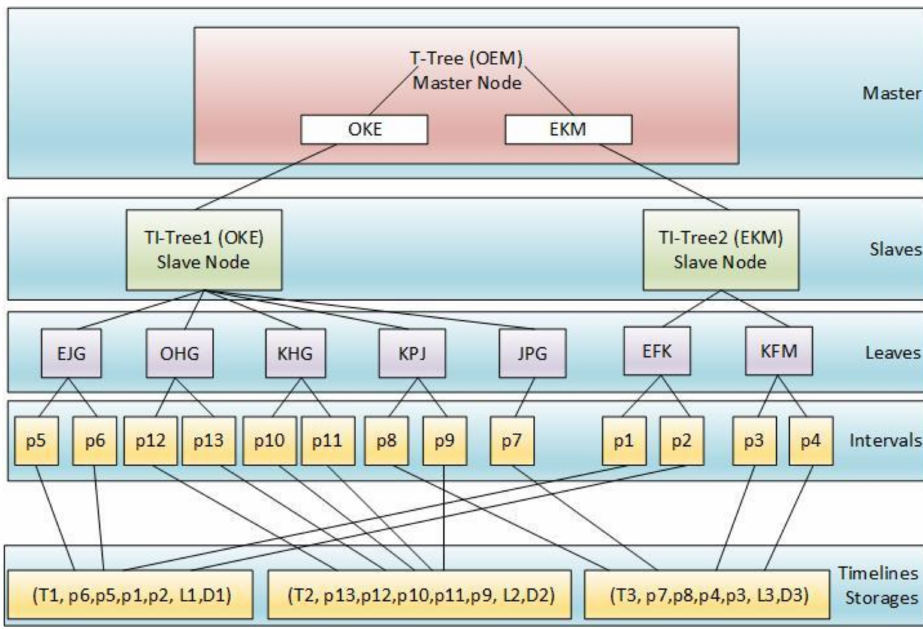
Figure 9. DTI-Tree index structure (example of Figure